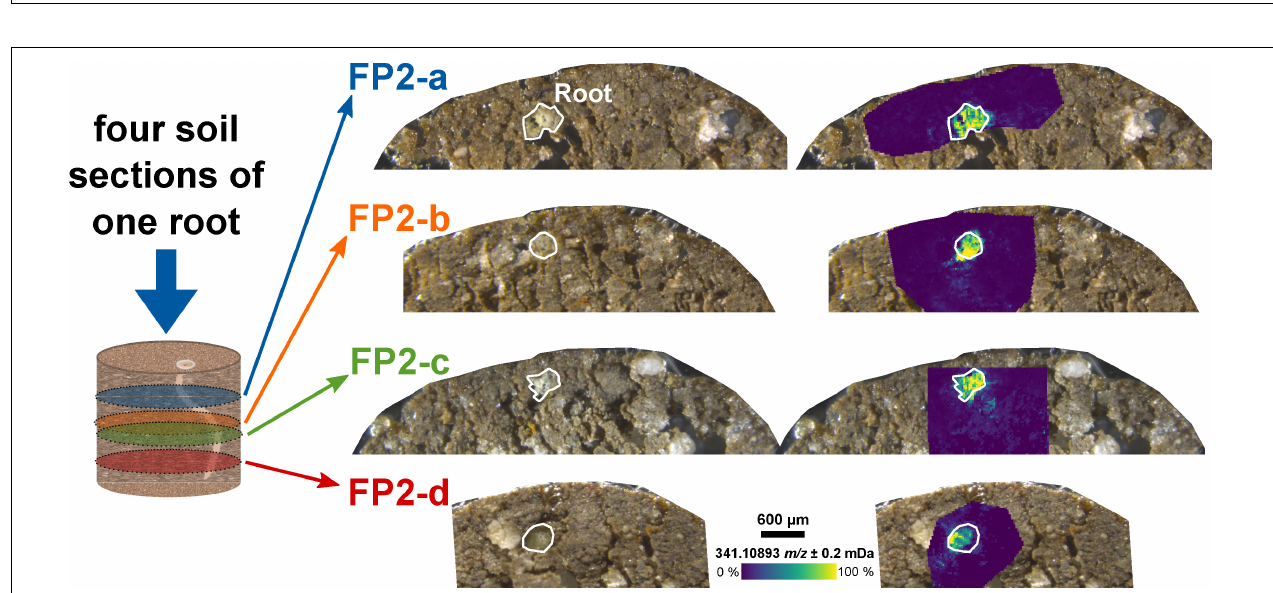
FIGURE 2 | Molecular gradient of the dihexose along the root axis. Optical images of the soil sections and overlay with the ion image for the dihexose signal [C 12 H 22 O 11 − H] − as detected by LDI-FT-ICR-MSI for the same root in different depths of an undisturbed soil sample from the field experiment. The root surface is highlighted in white.